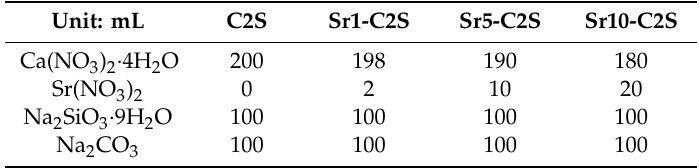
Table 1. Volume of 1 mol · L − 1 raw reagent solutions (Ca(NO 3 ) 2 · 4H 2 O, Sr(NO 3 ) 2 , Na 2 SiO 3 · 9H 2 O